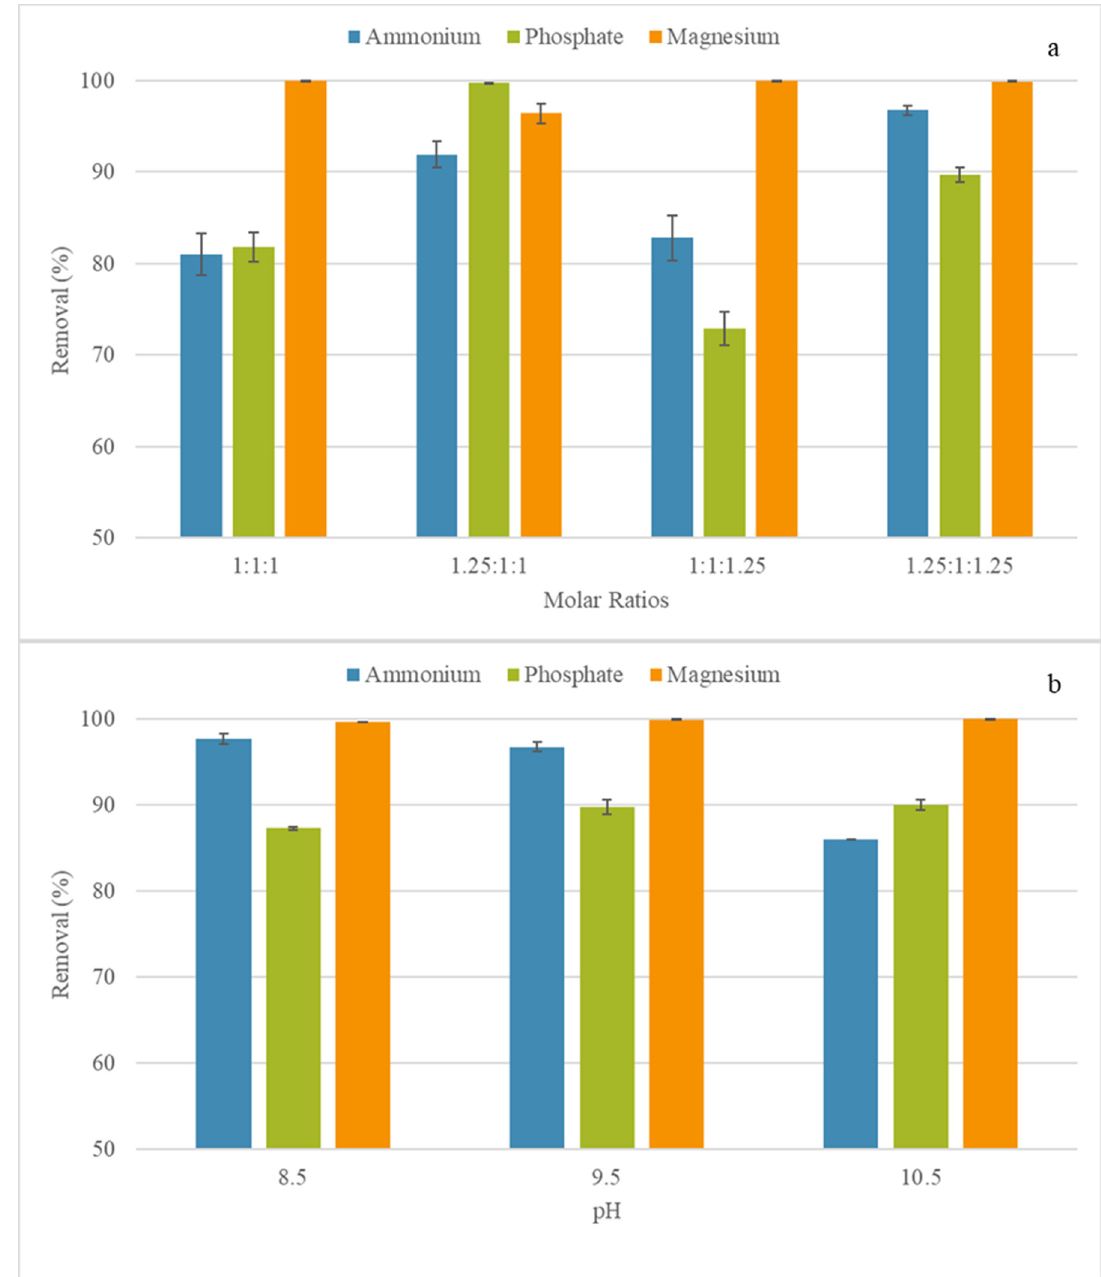
Figure 1. Ammonium, phosphate and magnesium removal rates vs. (Mg 2+ :NH 4+ :PO 43 − ) molar ratios at pH = 9.5 ( a ) and vs. pH at molar ratios of 1.25:1:1.25 ( b ). The error bars represent ± one standard deviation for three replicate experiments.